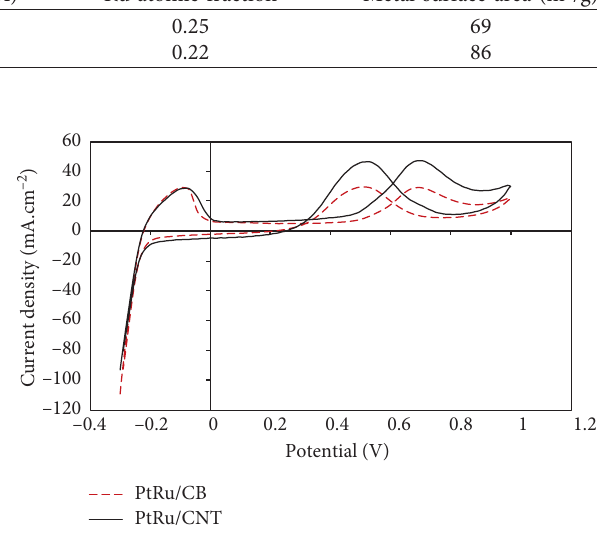
Figure 5: Cyclic voltammetry test of synthesized samples.